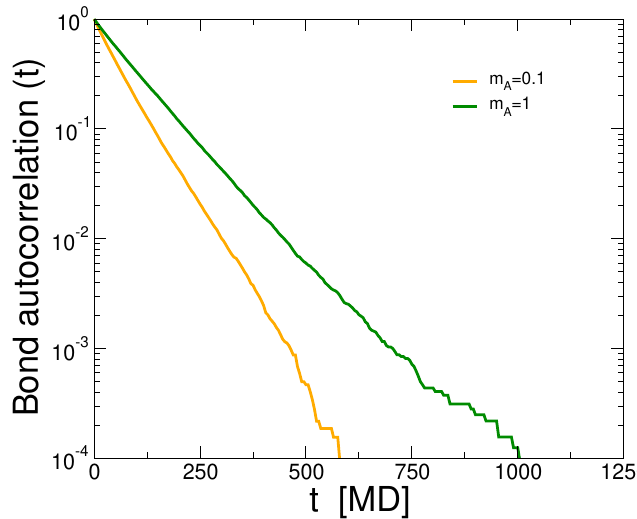
Figure 6: Comparison of the bond autocorrelation function evaluated for the lighter A particles bond (orange) and for the heavier (green). Data refer to k The characteristic time goes from 98 for the heavier, to 60 for the lighter. Notice that both of them decreased from the original value of 116 in Fig. 3, because now even the heavier particles have more bumps due to the faster light